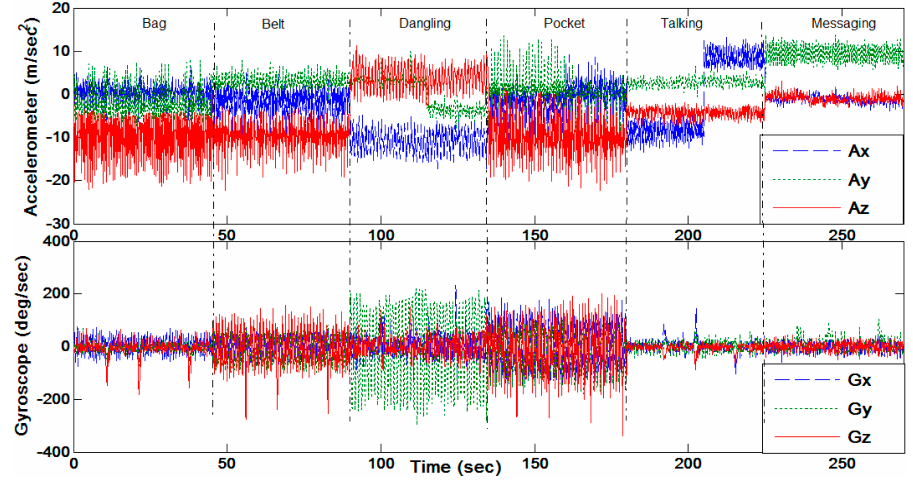
Figure 5. Calibrates accelerometers and gyros outputs in different placement mode.